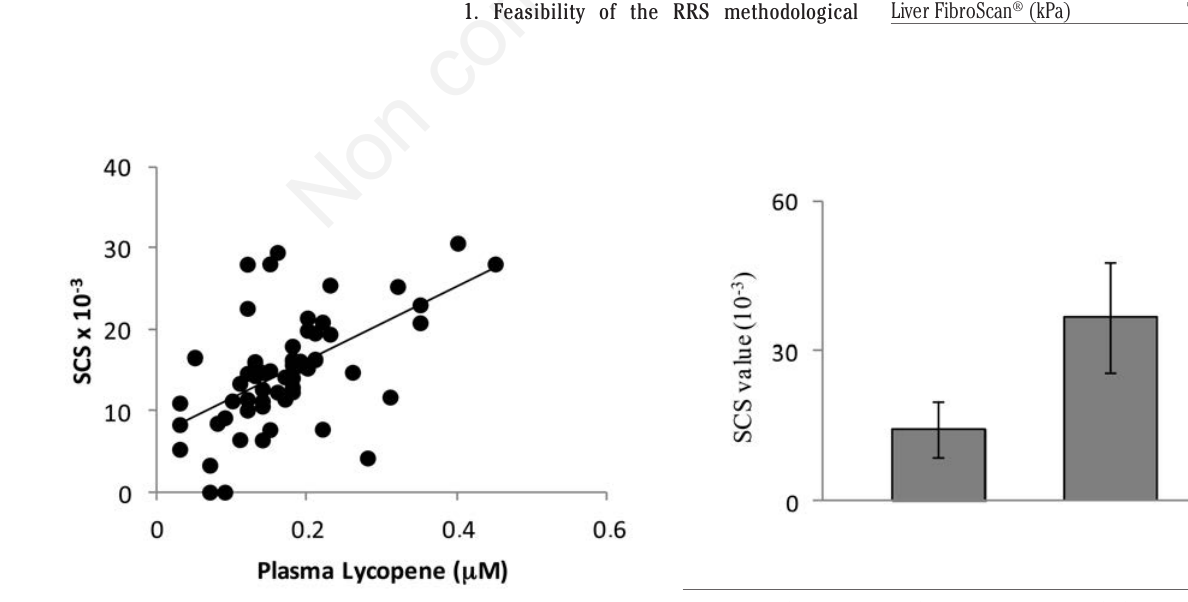
Figure 2. Skin carotenoid score (SCS) in b -thalassemia patients (left bar) as compared with healthy subjects (control, right bar). Values are the mean±SD of two measurements performed on 57 subjects during the year of the study. With respect to the control, values were significant with P<0.001 (Student’s